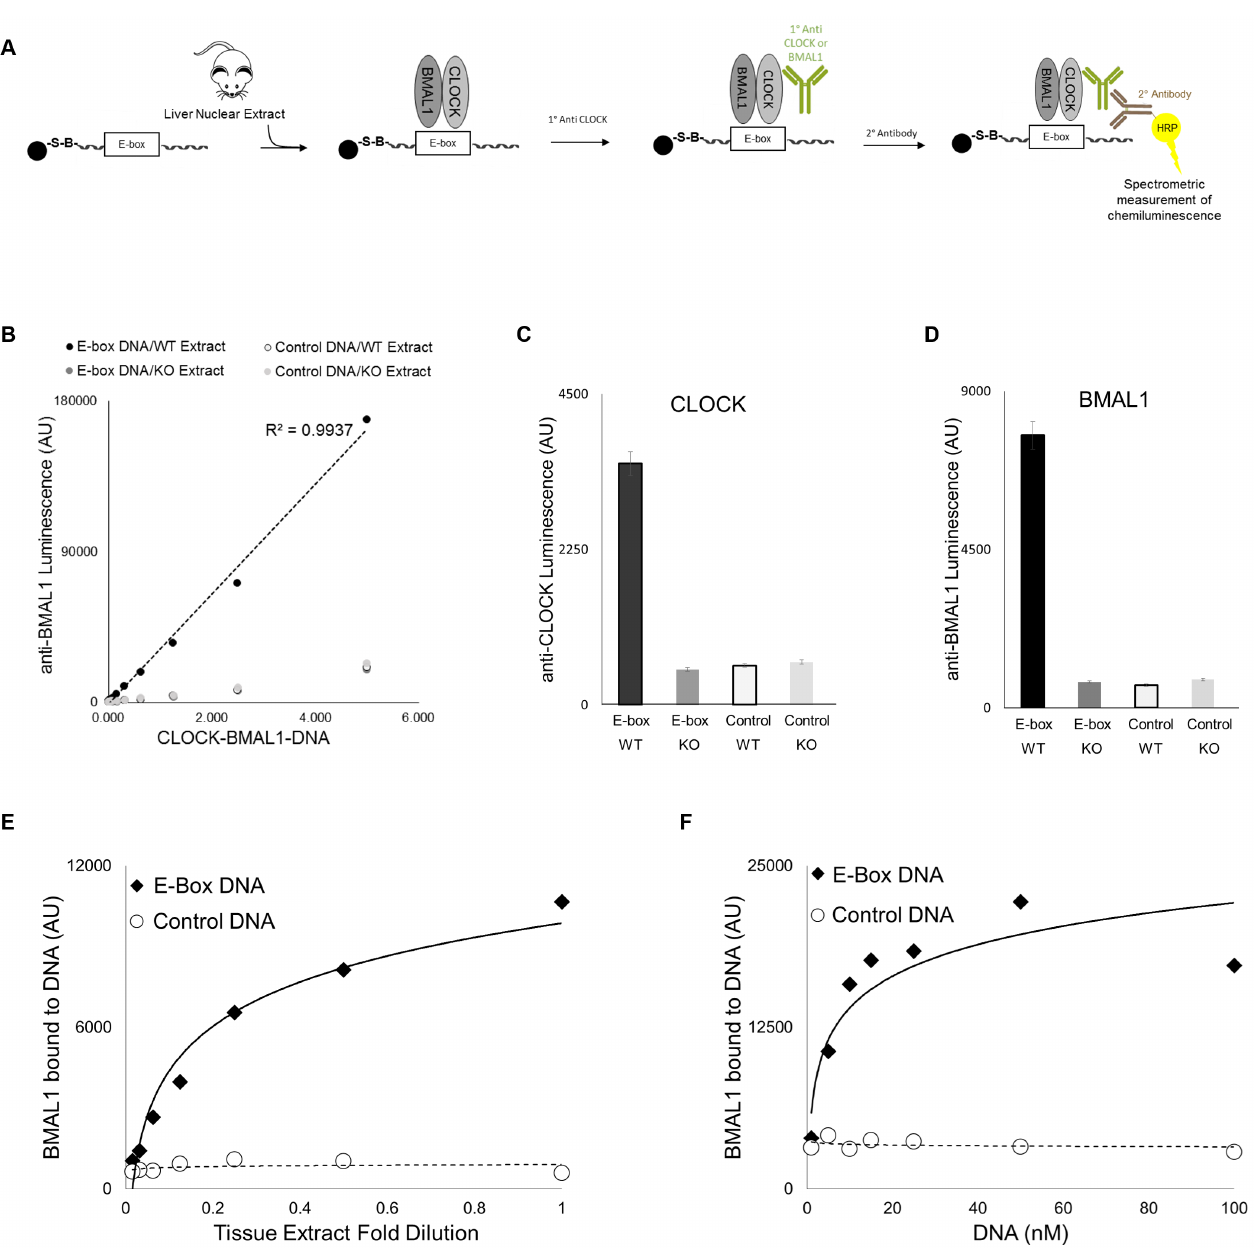
Figure 1. Relative quantitation and specificity of CLOCK-BMAL1 DNA binding by CPDBA. ( A ) CPDBA design. E-box DNA (or E-box scrambled Control DNA) is immobilized onto a bead substrate. Immobilized DNA is incubated with cell or tissue extract, washed, incubated with primary antibody against CLOCK or BMAL1, washed, incubated with secondary antibody (HRP linked), then washed a final time. The immobilized antibody-protein-DNA complex is then incubated with chemiluminescent substrate (ECL), and analyzed by spectrophotometry (luminescence at 425/60 nm). Counts are arbitrary units. ( B ) CPDBA was applied to WT nuclear extracts or Bmal1 − /− nuclear extracts (KO). The x-axis represents the amount of immobilized antibody-protein-DNA complex (in µl of magnetic beads), used in the final step of the CPDBA, and in the case of WT extract incubated with E-box DNA, corresponds to CLOCK-BMAL1-DNA probed withanti-BMAL1. This experiment was repeated (n=3) with a single volume of immobilized antibody-protein-DNA complex using anti-CLOCK ( C ) or anti-BMAL1 ( D ). BMAL1 binding to immobilized DNA was measured from a series of WT nuclear extract dilutions (1 = 16 µg of extract or 160 ng/µl final extract concentration with magnetic beads) while keeping the DNA concentration constant ( E ), or a series of DNA concentrations were used while keeping the extract concentration constant ( F